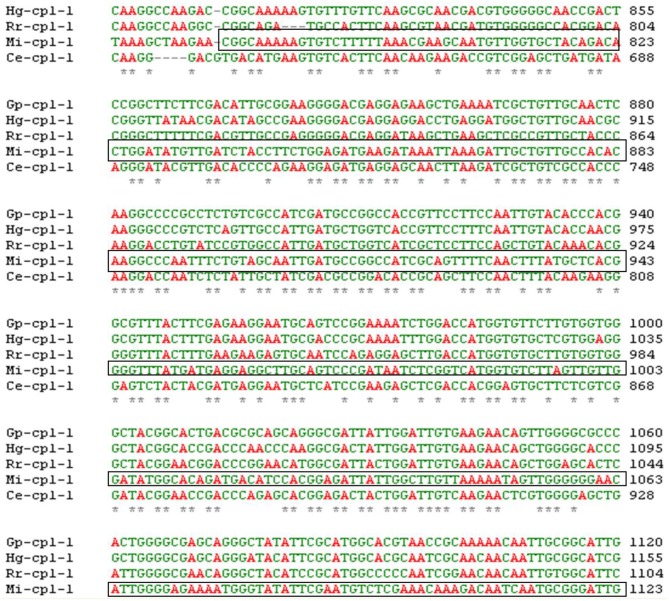
Multiple sequence alignment of Mi-Cpl-1 gene with the homologous gene sequences of different nematode species. *Shows the conserved region across the nematode species. Boxed portion indicates the target region of Mi-cpl-1 for RNAi studies. GenBank ID for Mi-Cpl-1 (1152 bp), Gp-Cpl-1 (1305 bp), Hg-Cpl-1 (1356 bp), Rr-Cpl-1 (1264 bp) and Ce-Cpl-1 (1192 bp) are AJ557572.1, AY999065.1, AY554271.1, AY999066.1, and NM_074798, respectively.